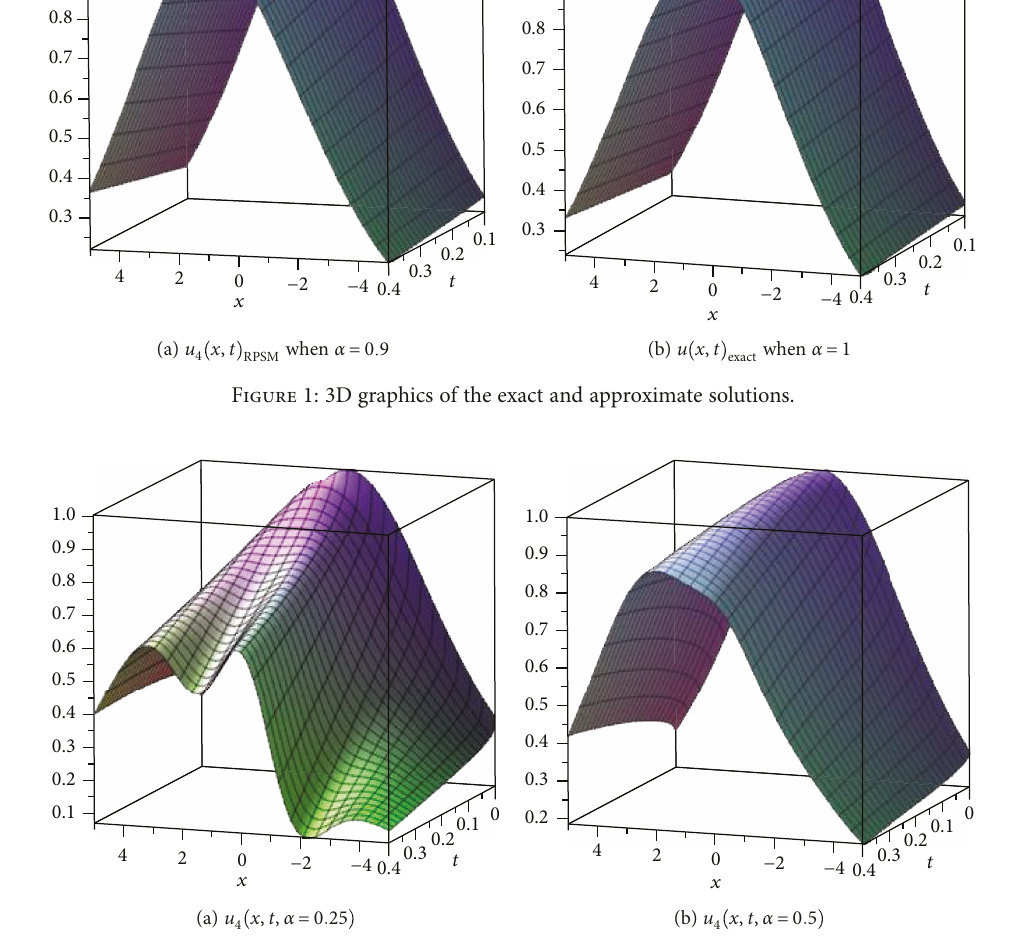
Figure 2: Approximate solution u